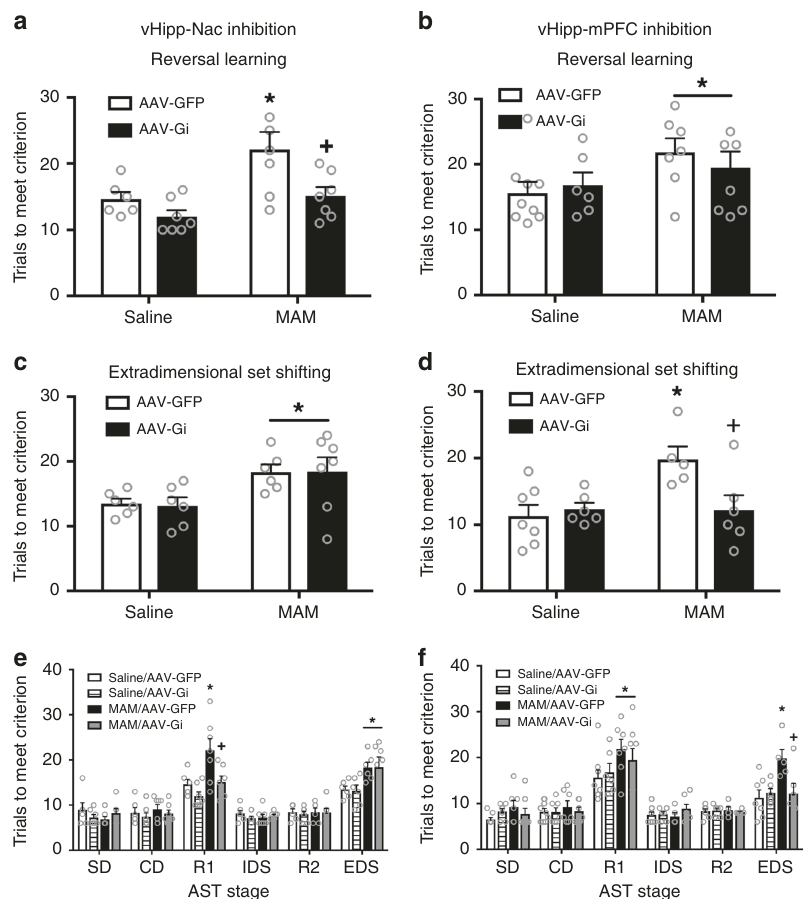
Fig. 5 vHipp-NAc and vHipp-mPFC pathways differentially affect distinct types of cognitive fl exibility. MAM treatment causes a de fi cit in both reversal learning and in extradimensional set-shifting. Inhibition of the vHipp-NAc pathway completely abolishes the MAM-induced de fi cit in reversal learning ( a ). Asterisk is signi fi cantly different than saline/GFP. Plus is signi fi cantly different than MAM/GFP. However, vHipp-NAc inhibition had no effect on extradimensional set-shifting ( c ). Asterisk is signi fi cant main effect of MAM. n = 6 – 7 rats per group. Conversely, inhibition of the vHipp-mPFC pathway had no effect on reversal learning performance ( b ) Asterisk is signi fi cant main effect of MAM. n = 6 – 9 rats per group. However, vHipp-mPFC inhibition did attenuate the MAM-induced de fi cit in extradimensional set-shifting ( d ). Aserisk is signi fi cantly different than saline/GFP; plus is signi fi cantly different than MAM/GFP. n = 6 – 7 rats per group. All stages of the AST are shown in e , ( f ). All data were analyzed using Two-Way ANOVA and Holm – Sidak tests. Data are shown as mean ± attenuated by inhibition of the vHipp-NAc pathway (MAM/Gi = The vHipp-mPFC pathway mediates set-shifting de fi cits . shifting de fi cits are not affected by inhibition of the vHipp-NAc pathway (Fig. 5c; two-way ANOVA: Interaction F (1,24) = 0.02,